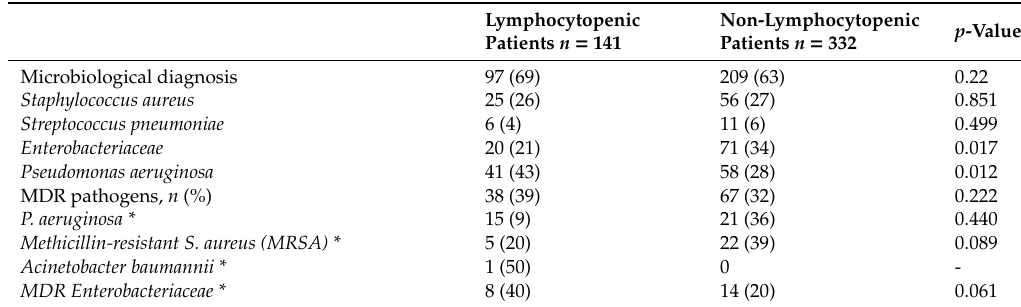
Table 2. Microbial